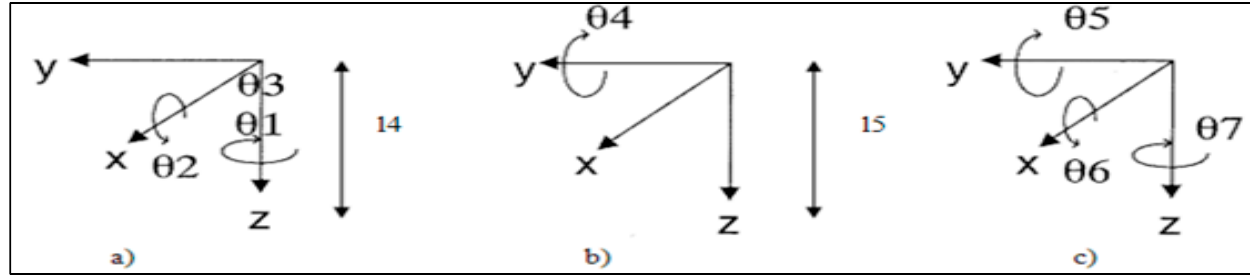
Figure 8. Denavit&Hartenberg Convention.